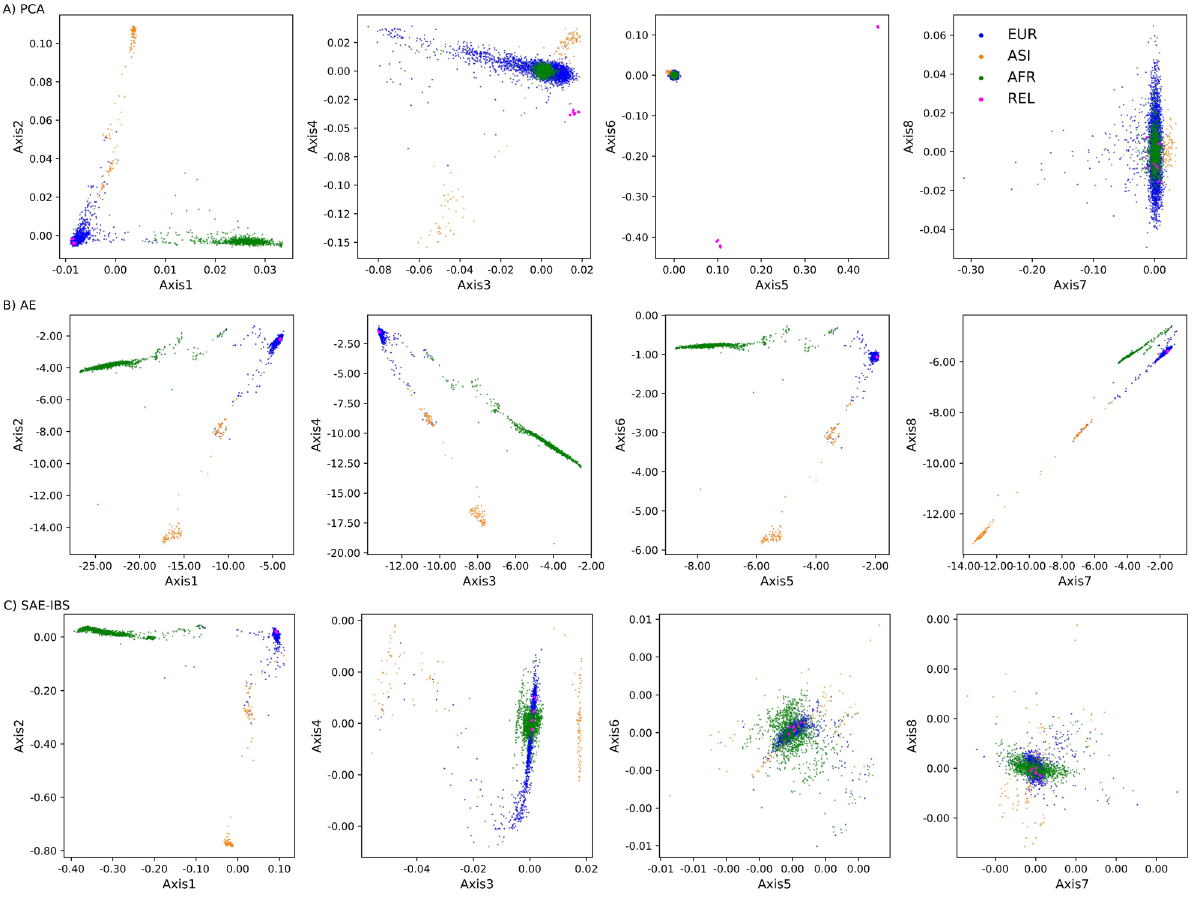
Figure 6. Comparison of population structure inference in the presence of related individuals. Scatter plots of the 8-dimensional ancestry space determined using ( A ) PCA, ( B ) AE, and ( C ) SAE-IBS, trained with MAE loss. The colors represent the self-reported ancestry of an individual, green for African (AFR), orange for Asian (ASI), and blue for European (EUR). Related individuals (REL) are plotted in pink.